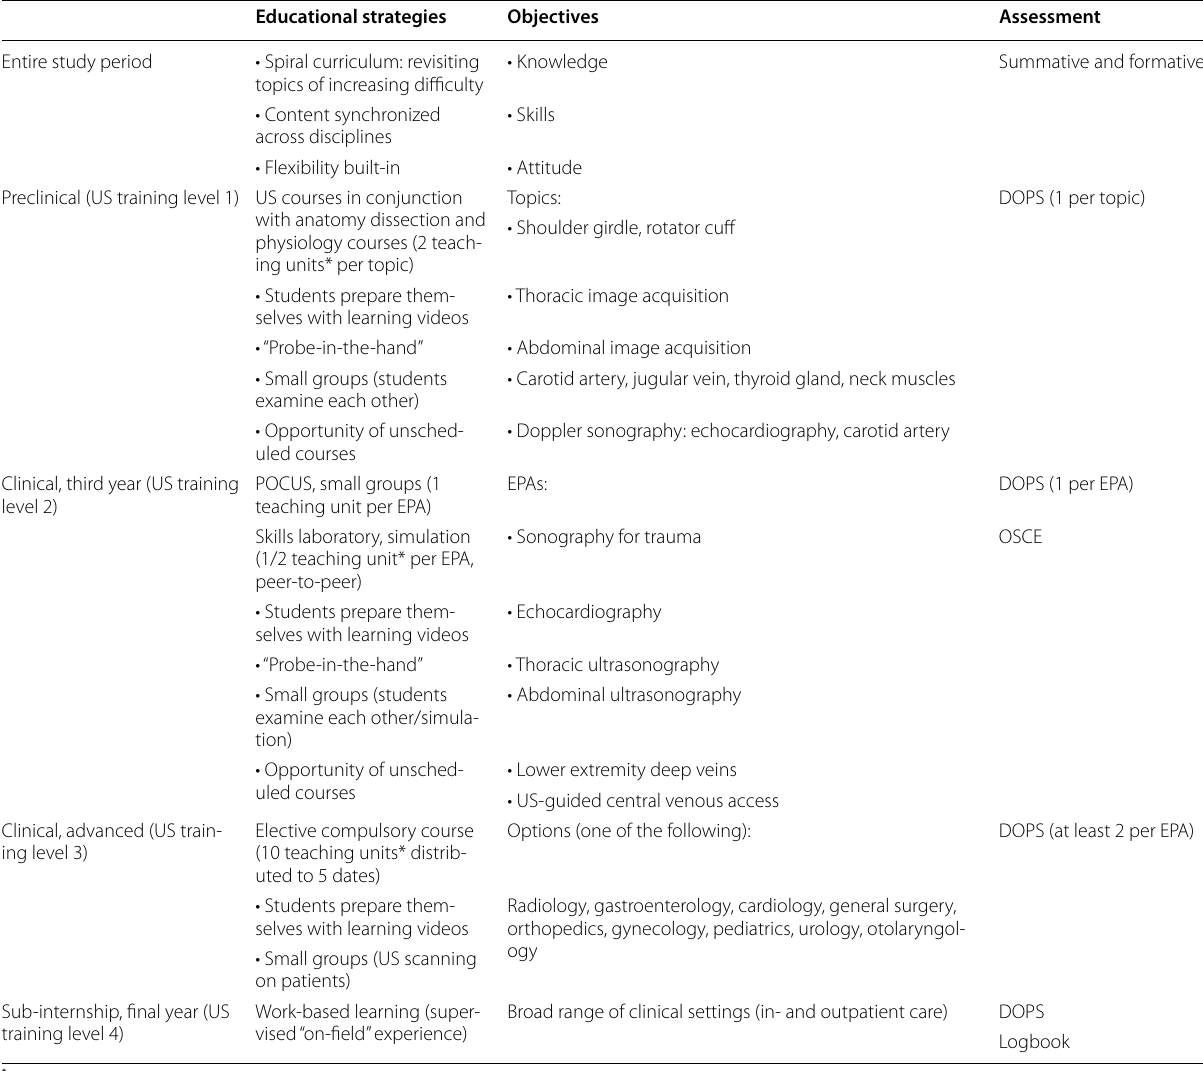
Table 1 Proposed compulsory longitudinal ultrasonography